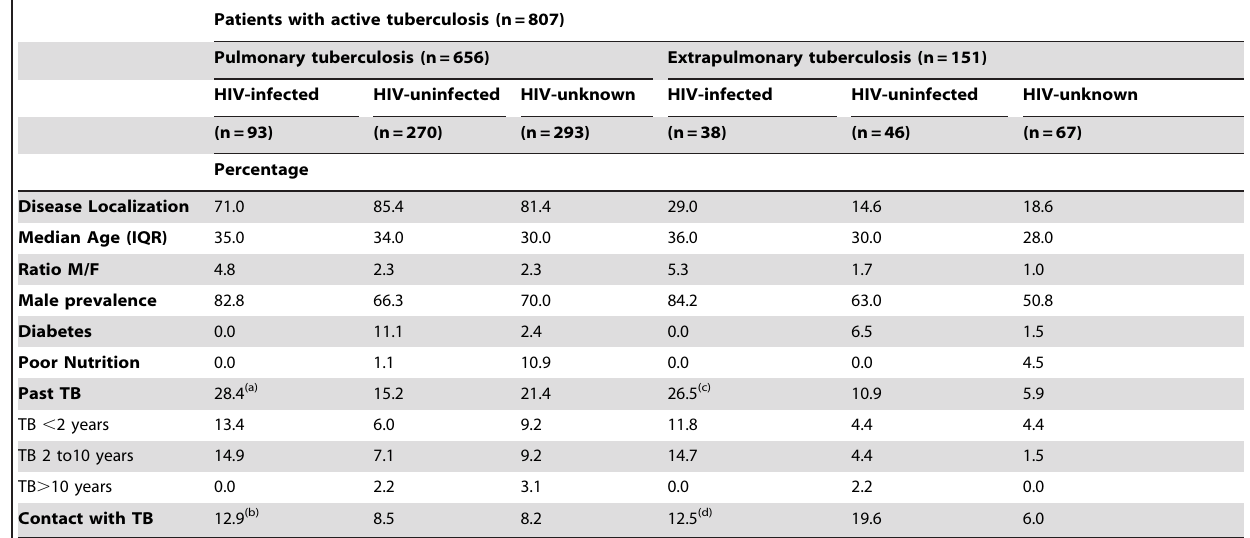
Table 1. Demographic and clinical characteristics of the patients with active tuberculosis.